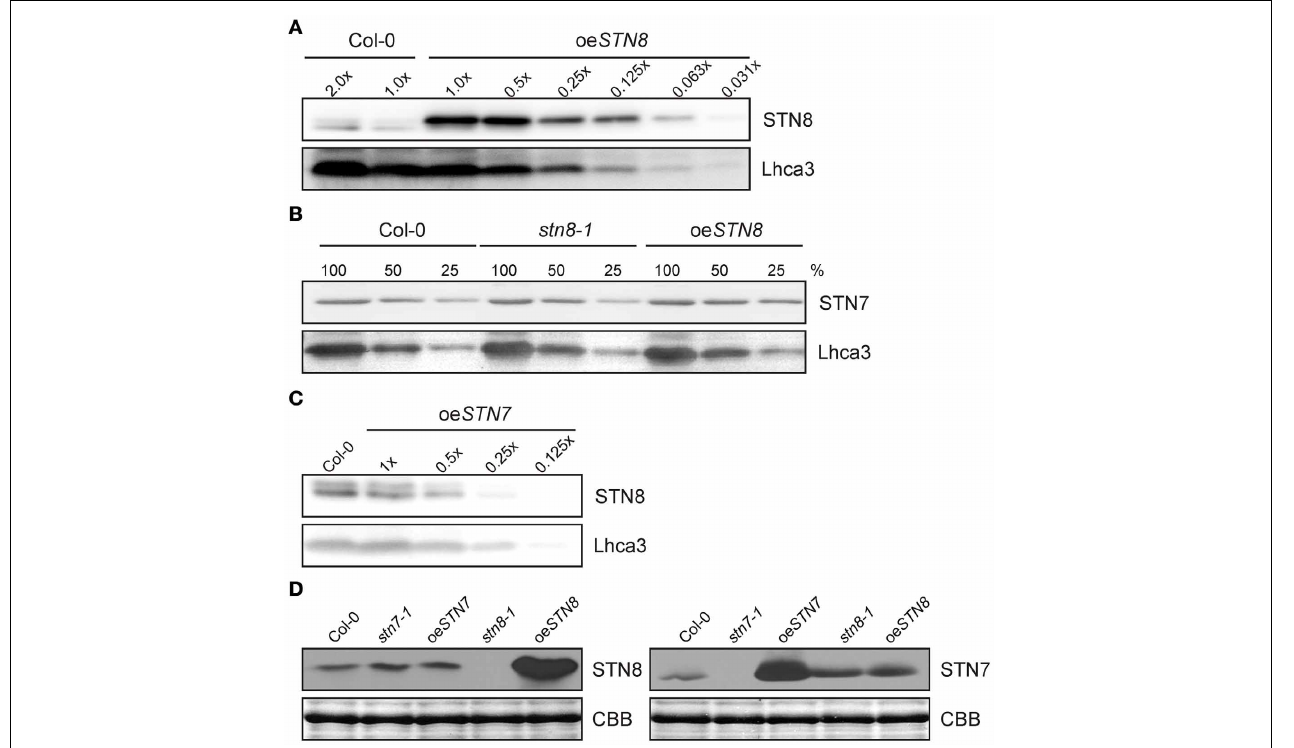
FIGURE 1 | Non-interdependence of STN kinase accumulation. (A) WT (Col-0) thylakoid proteins corresponding to 10 μ g (2.0 × ) and 5 μ g (1.0 × ) of Chl and serial dilutions of oe STN8 thylakoids were loaded to quantify the levels of STN8 protein in oe STN8 plants. Proteins were subjected to SDS-PAGE and Western blot analysis using STN8- and Lhca3-specific antibodies. (B) STN7 accumulation in thylakoids of WT (Col-0), oe STN8 and stn8-1 mutant plants. Thylakoid proteins, corresponding to 8 μ g (100%), 4 μ g (50%), and 2 μ g (25%) of Chl, from each genotype were loaded on a SDS gel and probed using specific antibodies against STN7 and Lhca3 (as loading control). (C)